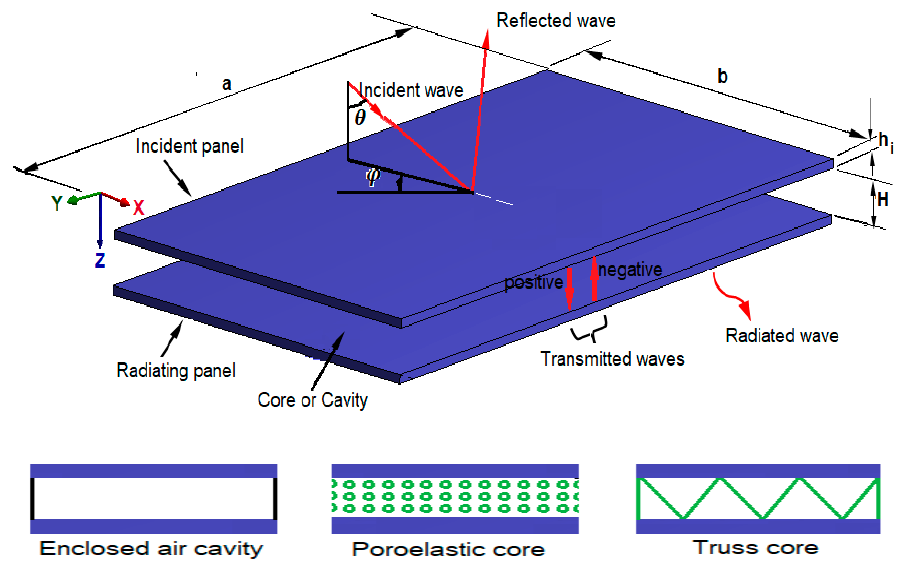
Figure 5. Schematic representation of sandwich composite flat panels with di ff erent core and cavity types.